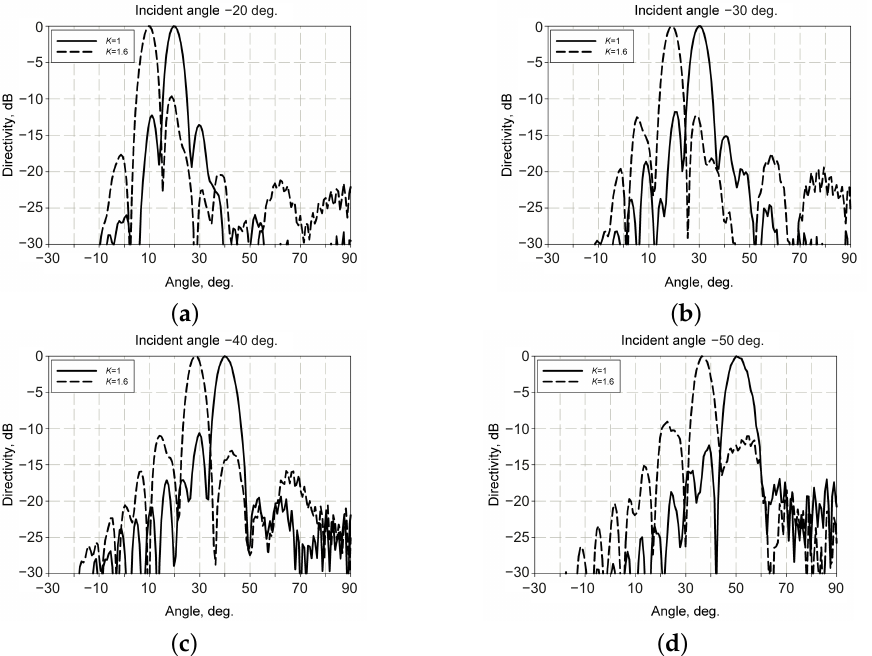
Figure 6. Simulated radiation patterns for outdoor implementation of reflector at at different incident angles form ( a ) 20 ( b ) 30 ( c ) 40 ( d ) 50 deg. for 60GHz operating − − − −